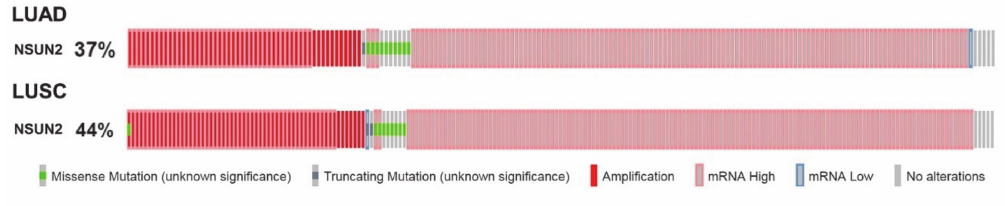
Figure 3. cBioportal analysis of The Cancer Genome Atlas (TCGA) lung adenocarcinoma (LUAD) and lung squamous cell carcinoma (LUSC)